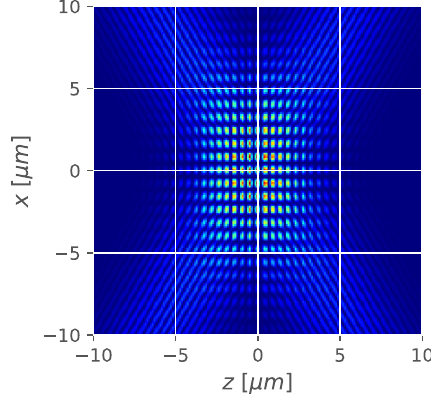
FIG. 2. Intensity pattern of the interference of the colliding laser